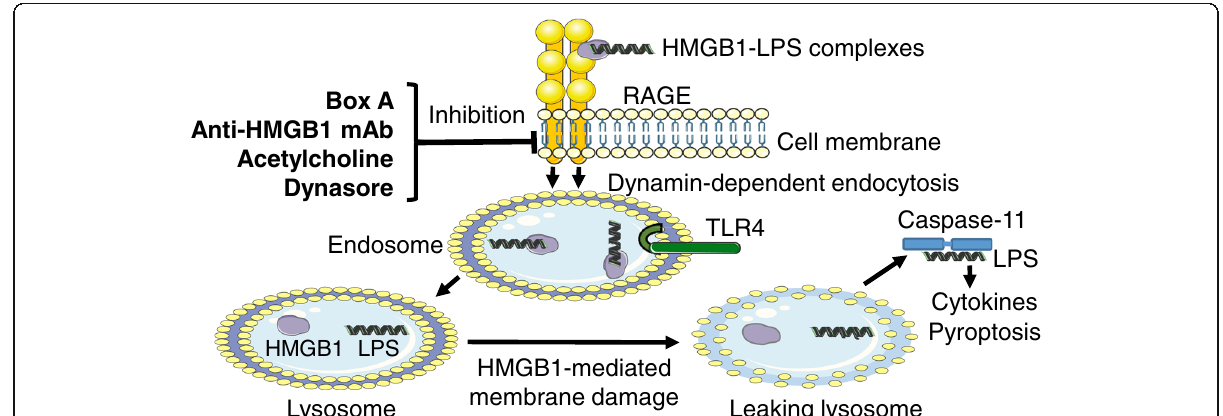
Fig. 8 Molecules inhibiting RAGE-mediated endocytosis of LPS-HMGB1 complexes. The pathogenesis of endotoxemia is caused by extracellular LPS getting attaching to extracellular HMGB1 and forming a complex that is endocytosed via RAGE-dependent pathway. Both LPS and HMGB1 then activate endosomal TLR4 receptors before being transferred to the lysosomal system. HMGB1 permeabilizes lysosomal membranes under acidic conditions and thus allows LPS to avoid lysosomal degradation and leaks out into the cytosol (Deng et al. 2018a). LPS is thus enabled to activate its key cytosolic receptor, caspase-11 in murine macrophages to induce pyroptosis. The discoveries of the present study are that box A, anti-HMGB1 m2G7 and acetylcholine each inhibits the cellular internalization of LPS-HMGB1 complexes and subsequent immune